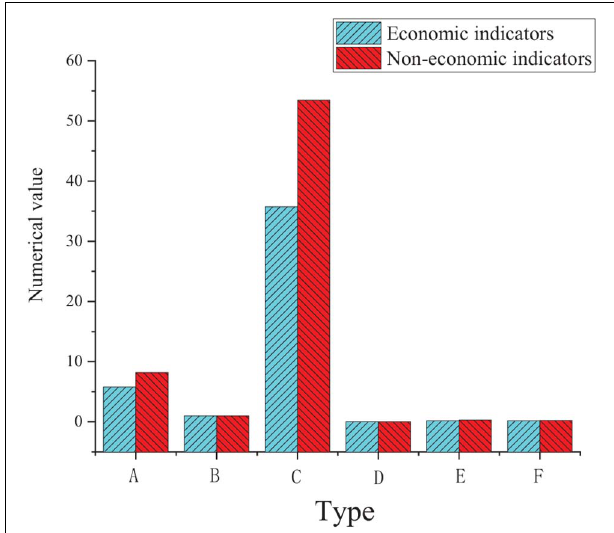
FIGURE 7 | Multiple regression analysis of risk taking and entrepreneurial performance at all levels (A, β value; B, t value; C, VIF value; D, F test; F Sig.; E, R 2 ; F, (cid:77) R 2 ).